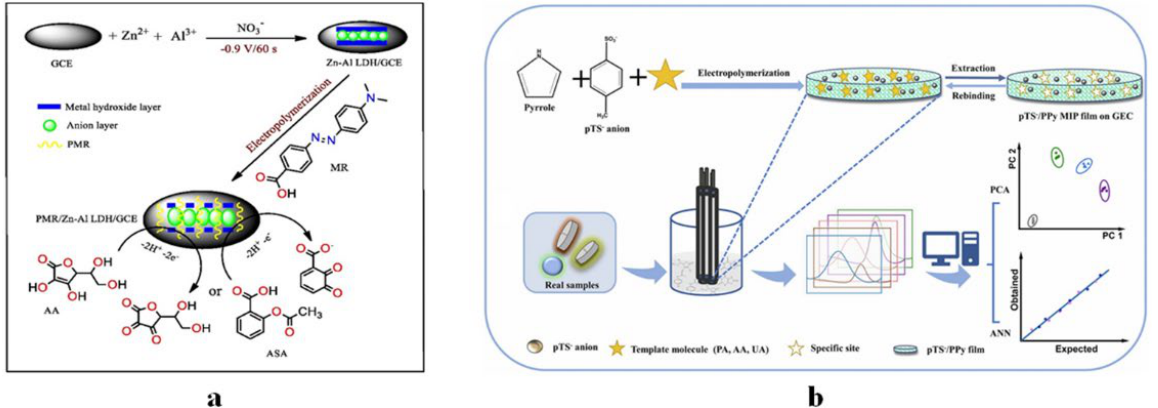
Figure 7. ( a ) Schematic fabrication of the PMR/Zn-Al LDH/GCE for the determination of AA or ASA. Reprinted with permission from Ref. [47]. Copyright 2022, Wiley-VCH GmbH. ( b ) Preparation